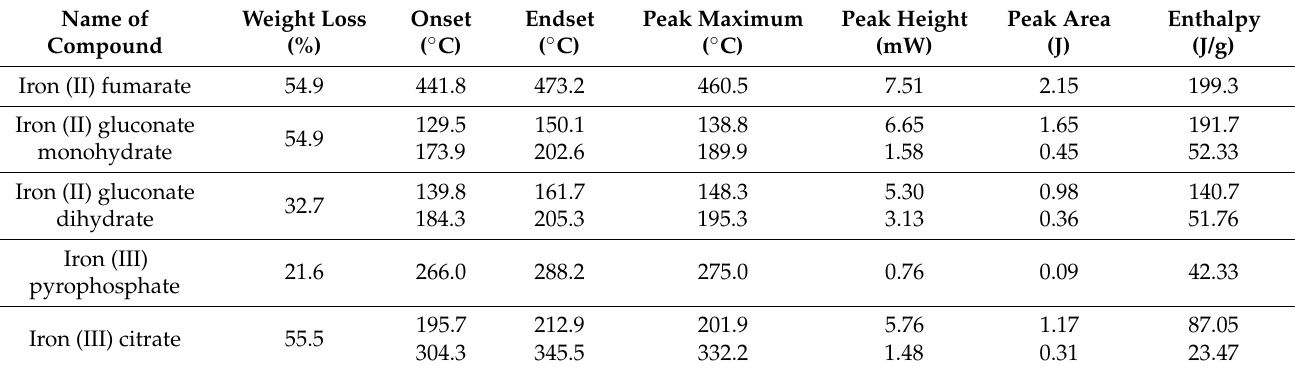
Table 5. Parameters determined from TG and DSC analysis for pure iron compounds: iron (II)